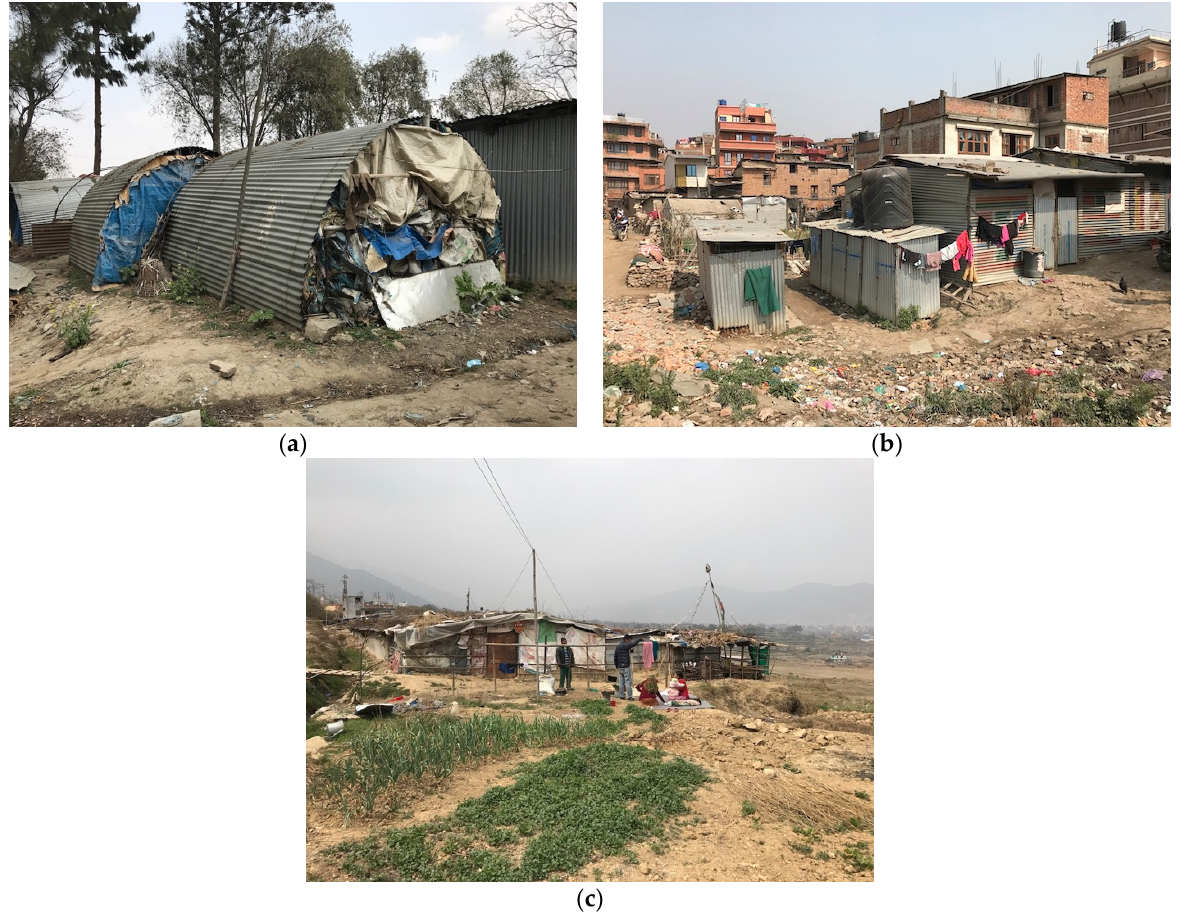
Figure 2. Examples of temporary shelters in camps and displacement sites ( a ) Inachok; ( b ) Khokana; ( c ) Khadga Gaun. (Photographs by A. Titz 2018).